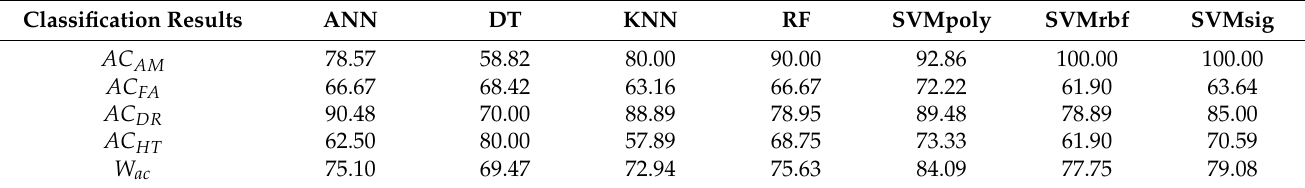
Table 5. Overall weighted accuracy of four species and the classification accuracy of each species achieved by all classification models.